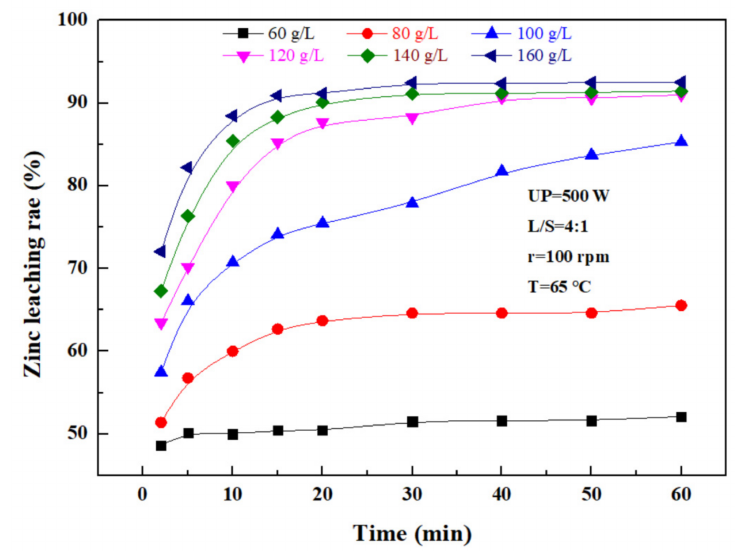
Figure 7. Effect of the sulfuric acid concentration on the zinc leaching rate.